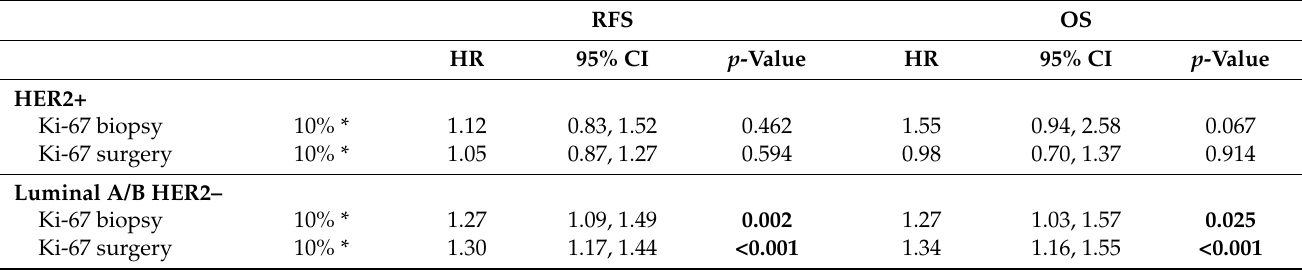
Table 5. Multivariable analysis of Ki-67 expression adjusted to age and pathological tumor and nodal stage for RFS and OS according to BC